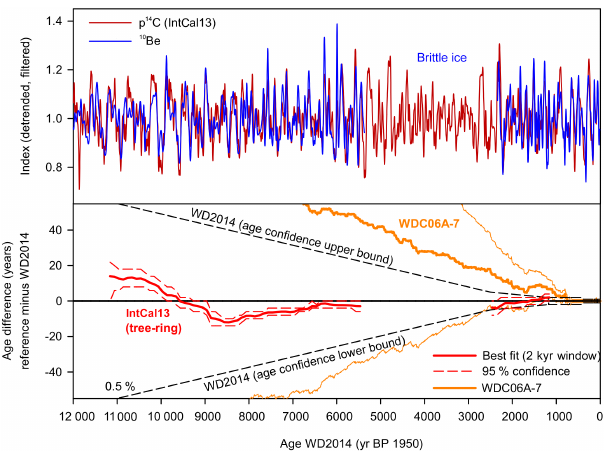
Figure 9. Comparison to the independent chronology IntCal13. Up- per panel: filtered 10 Be (blue) and 14 C (red) data on their respec- tive timescales. Lower panel: most likely time shift (red line) for the highly significant correlations together with the 2 σ uncertainty range inferred from the r 2 distribution. Results are superimposed on a WD2014 age uncertainty envelope using an absolute age un- certainty of 0.5% over most of the Holocene. For the most recent 2500 years we estimate the uncertainty envelope to be smaller than ± 5 years (Sigl et al., 2015). Also shown is the difference between the WAIS Divide chronologies (WDC06A-7 minus WD2014), indi- cating consistently younger ages for WD2014. Ice corresponding to the age interval 2.5–5.4ka has not been sampled for 10